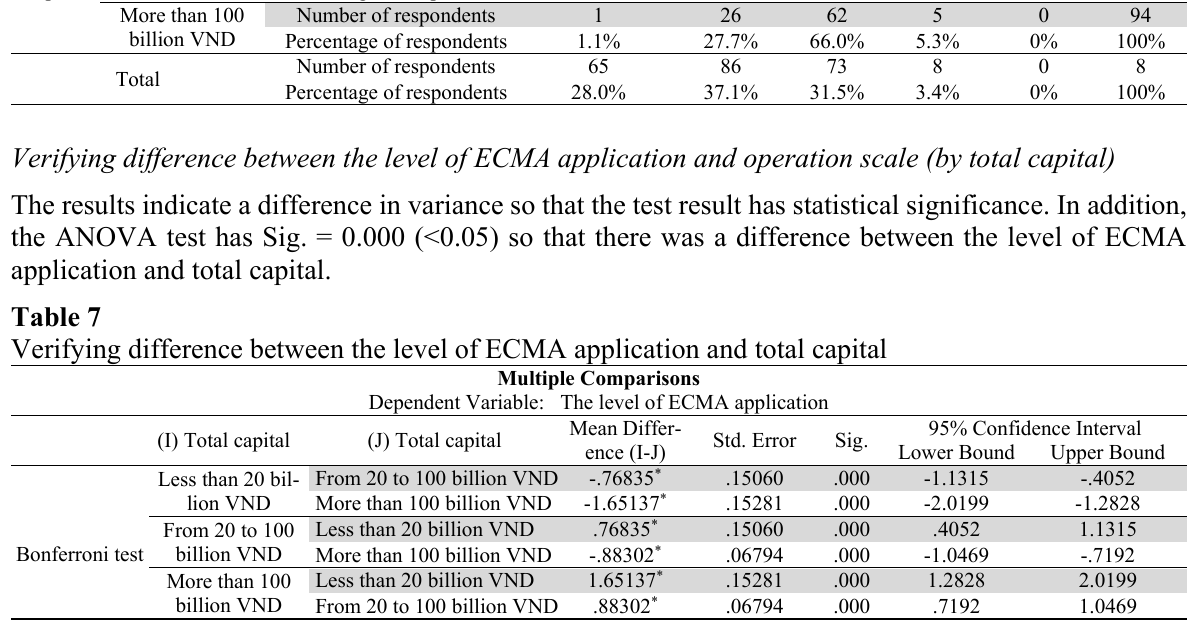
Relationship between the level of ECMA application and total capital Total capital